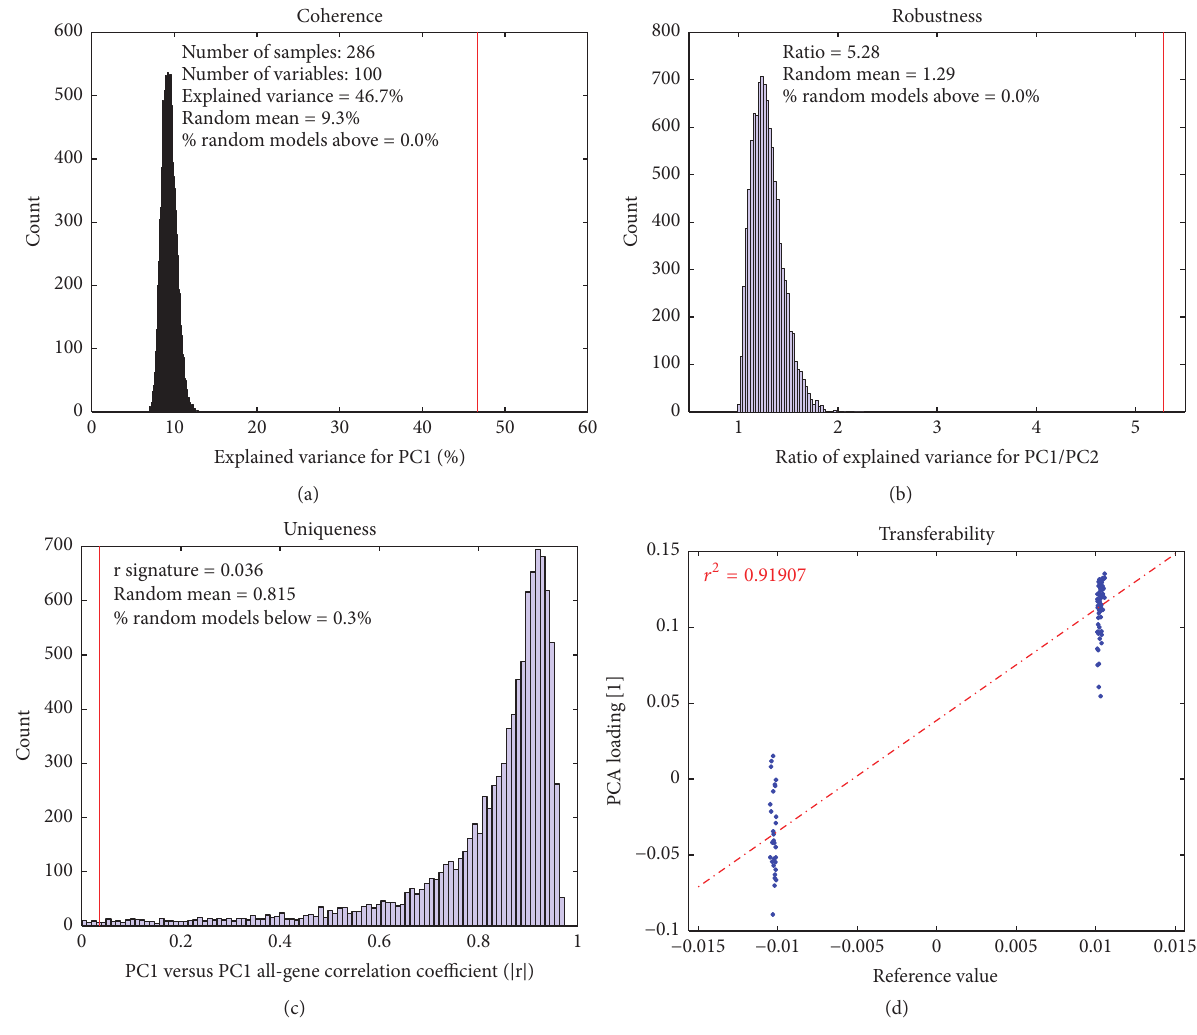
Figure 4: Validation plot for TvsN-100 signature applied to Breast dataset. To demonstrate a signature that is valid within the Breast dataset, the TvsN-100 gene signature was applied. The probesets for the TvsN-100 signature are coherent (a), and the PCA model is robust (b). The signature is also unique (c) and describes the same biology as in the dataset that it was trained upon (d).